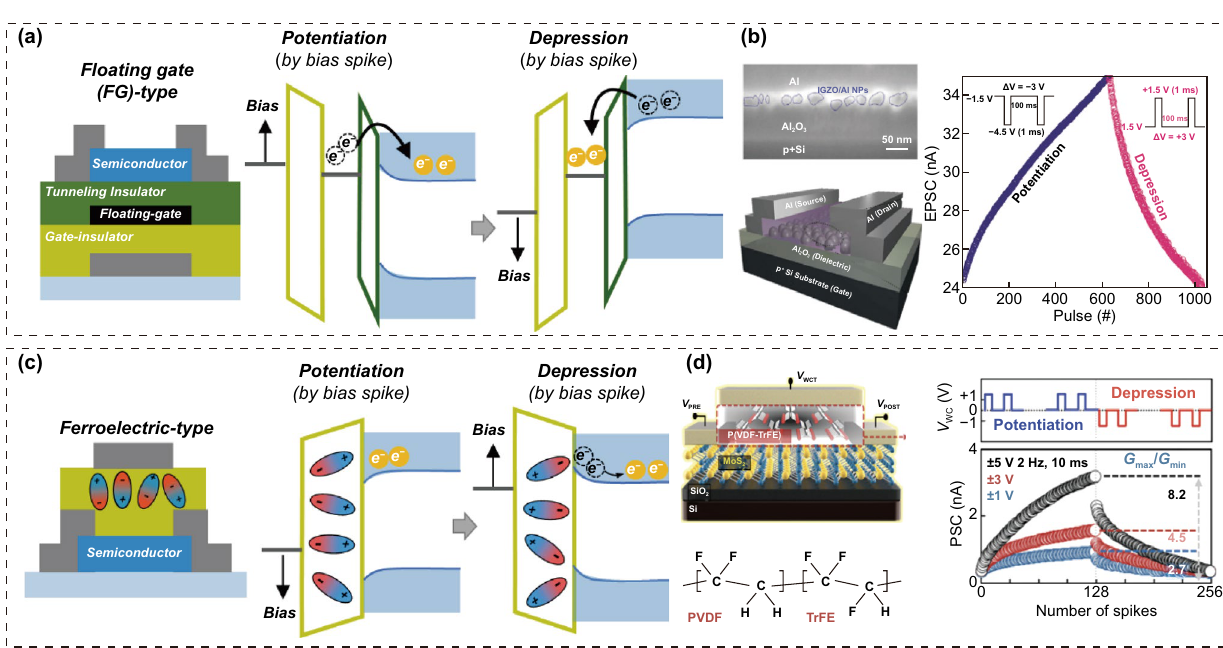
Fig. 5 Floating‑gate (FG) transistor‑type ES; a operation mechanism, and b Al nanoparticles (NPs)‑FG transistor‑type ES. Ferroelectric tran‑ sistor‑type ES; c operation mechanism and d poly(vinylidene fluoride)‑trifluoroethylene (PVDF‑TrFE) ferroelectric transistor‑type ES. b Repro‑ duced with permission from Ref. [30]. Copyright @ 2020, Wiley‑VCH. d Reproduced with permission from Ref. [35]. Copyright @ 2021, Royal society of chemistry